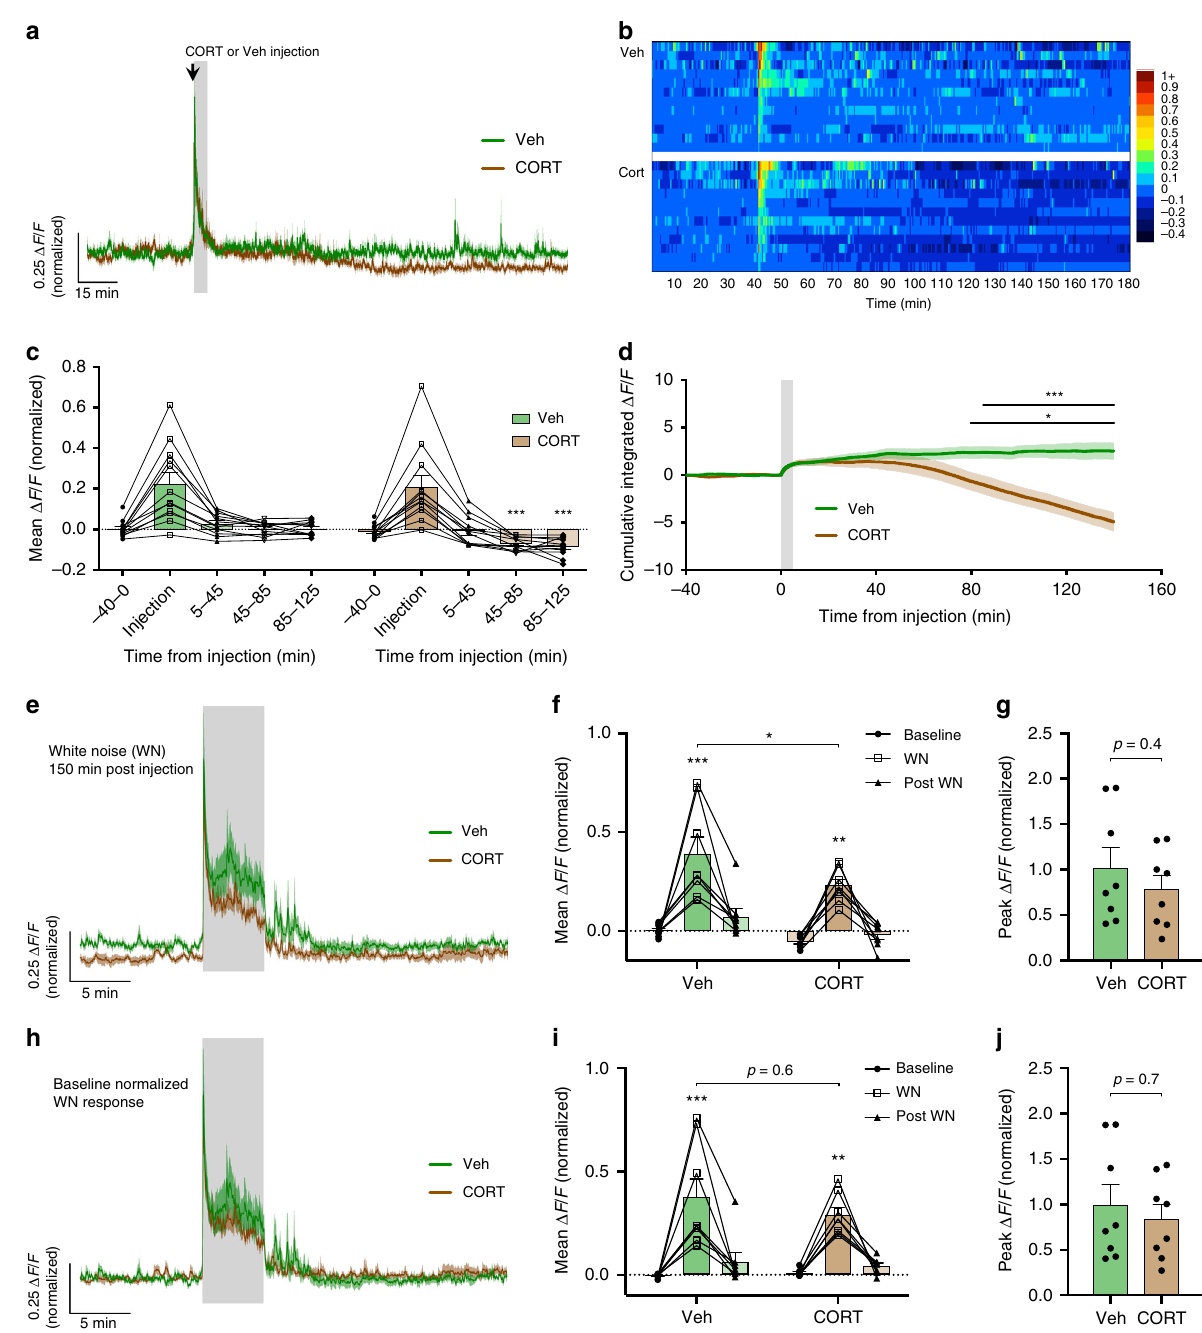
Fig. 4 CORT-negative feedback slowly suppresses basal but not stress-evoked CRH neuron activity. a Mean photometry signals of CRH neuron activity from vehicle- and CORT-treated mice. Gray shaded area indicates time of injection where handling/injection stress response is evident. b Heatmap of mean CRH neuron activity from all individual mice in 30 s bins. c Mean Δ F / F changes in 40 min bins; n = 12 per group, RM two-way ANOVA, *** p < 0.001 vs. baseline, Holm – Sidak; ANOVA interaction p < 0.001, ANOVA main effect of group p < 0.001. CRH neuron activity during injection stress (5 min bin) was not included in the statistical analysis. d Cumulative integrated Δ F / F of tonic CRH neuron activity; RM two-way ANOVA, * p < 0.05 Veh vs. CORT, Holm – Sidak; ANOVA interaction p < 0.001, ANOVA main effect of group p = 0.025. Lines indicate points at which statistical signi fi cance was reached and its duration. Gray shaded area indicates stress response due to injection. e Averaged photometry recordings of the WN stress response 150 min after injection without baseline normalization. f Average Δ F / F across 5 min of CRH neuron activity before, during, and after WN stress without baseline normalization; n = 8 per group, RM two-way ANOVA, * p < 0.05 vs. baseline (unless otherwise indicated), Holm – Sidak; ANOVA interaction p = 0.45, ANOVA main effect of group p = 0.01. g Peak Δ F / F at WN onset without baseline normalization; Mann – Whitney test. h Averaged photometry recordings of the WN stress response 150 min after injection with baseline normalized to 10 min of activity prior to white noise. i Average Δ F / F across 5 min of CRH neuron activity before, during, and after WN stress after baseline normalization; n = 8 per group, RM two-way ANOVA, * p < 0.05 vs. Baseline, Holm – Sidak; ANOVA interaction p = 0.48, ANOVA main effect of group p = 0.47. j Peak Δ F / F at WN onset after baseline normalization; Mann – Whitney test. All data are presented as mean ± SEM, * p < 0.05, ** p < 0.01, *** p <